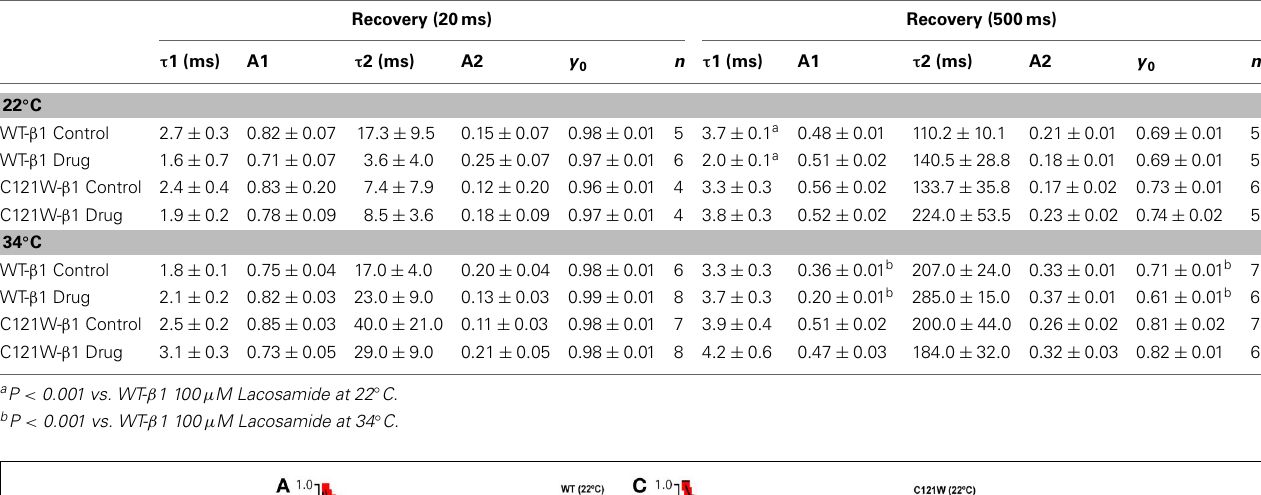
Table 4 | Fast inactivation recovery.